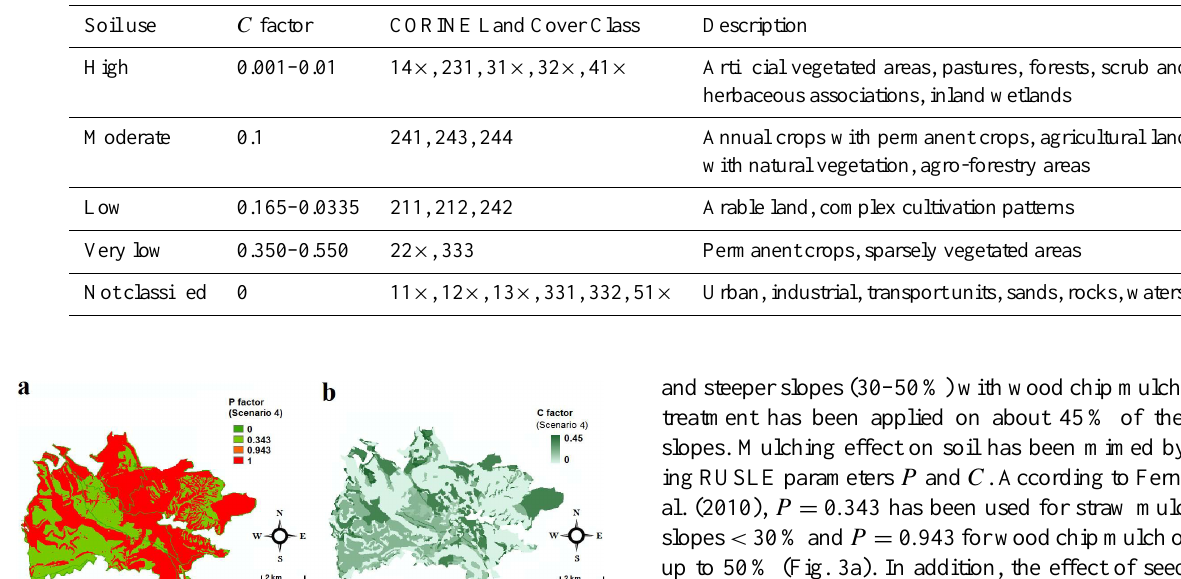
Table 3. The C factor after 2006 CORINE Land Cover classification.